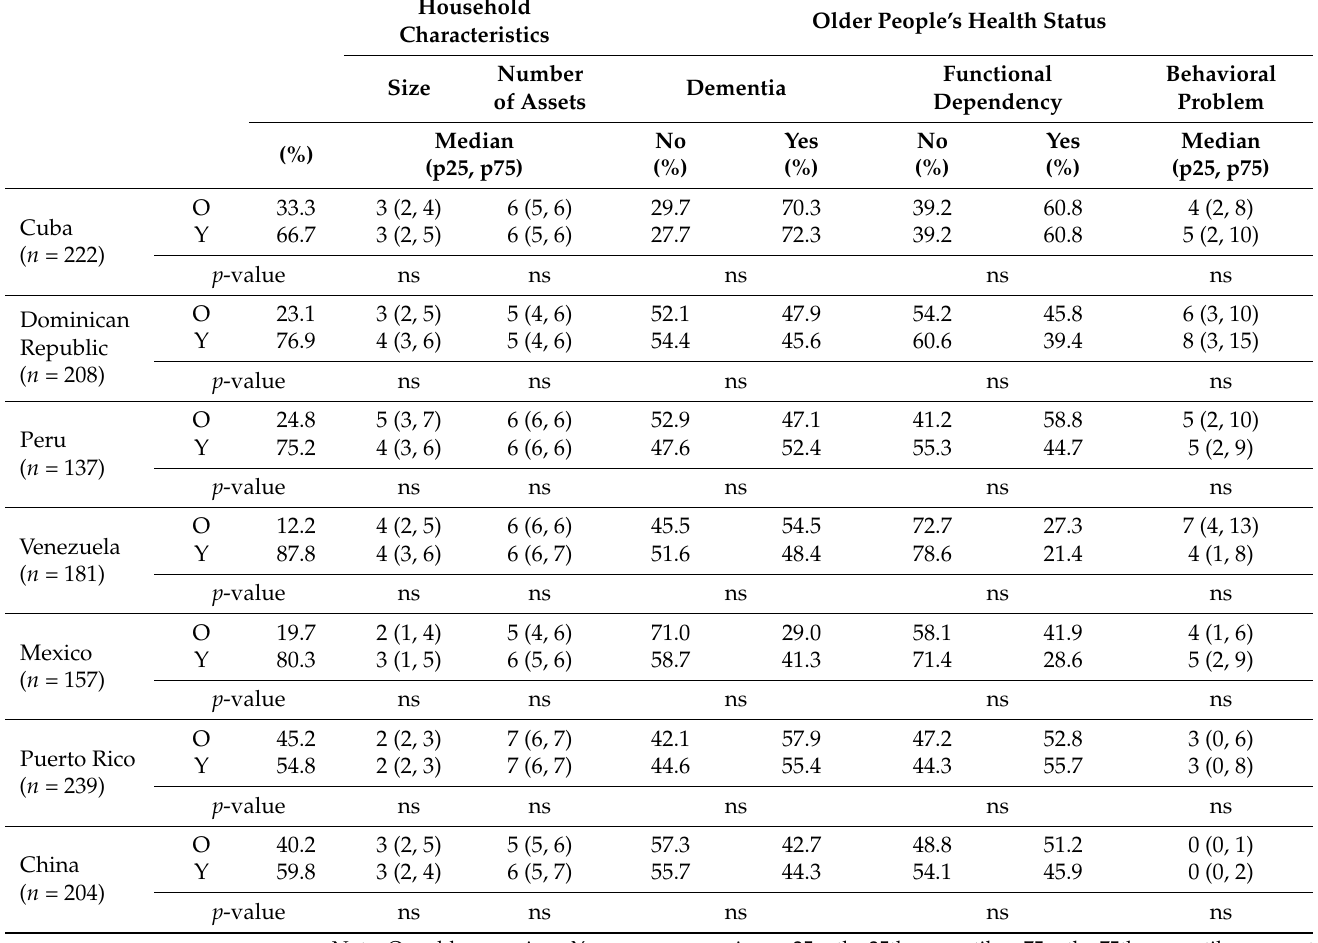
Table 1. Percentage of caregiver’s age group and the background characteristics of households and older people in seven countries ( n = 1348 households). Household Older People’s Health Status Characteristics Number of